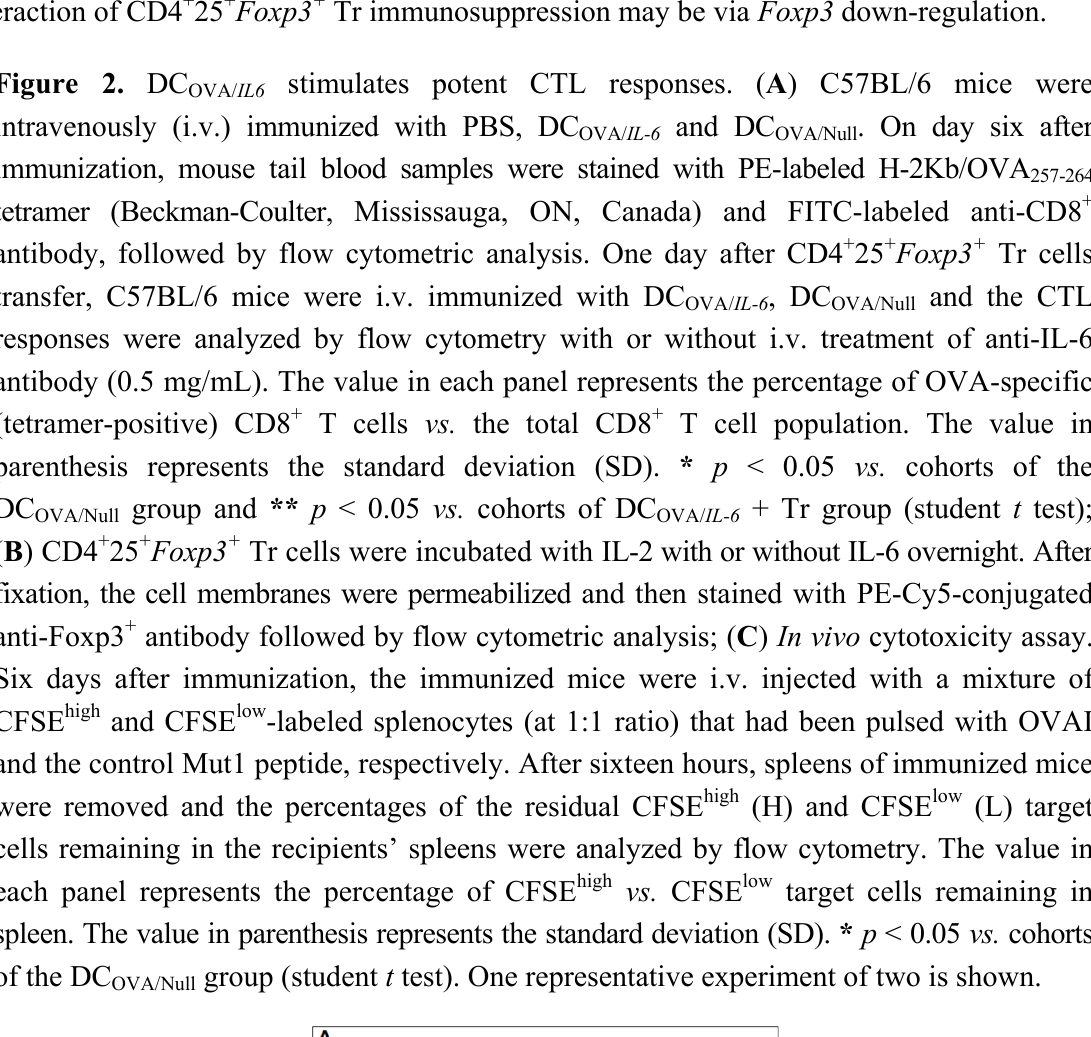
counteraction of CD4 + 25 + Foxp3 + Tr immunosuppression may be via Foxp3 down-regulation. Figure 2. DC stimulates potent CTL responses. ( A ) C57BL/6 mice were OVA/ IL6 intravenously (i.v.) immunized with PBS, DC and DC . On day six after OVA/ IL-6 OVA/Null immunization, mouse tail blood samples were stained with PE-labeled H-2Kb/OVA 257-264 tetramer (Beckman-Coulter, Mississauga, ON, Canada) and FITC-labeled anti-CD8 + antibody, followed by flow cytometric analysis. One day after CD4 + 25 + Foxp3 + Tr cells , DC and the CTL transfer, C57BL/6 mice were i.v. immunized with DC OVA/ IL-6 OVA/Null responses were analyzed by flow cytometry with or without i.v. treatment of anti-IL-6 antibody (0.5 mg/mL). The value in each panel represents the percentage of OVA-specific (tetramer-positive) CD8 + T cells vs. the total CD8 + T cell population. The value